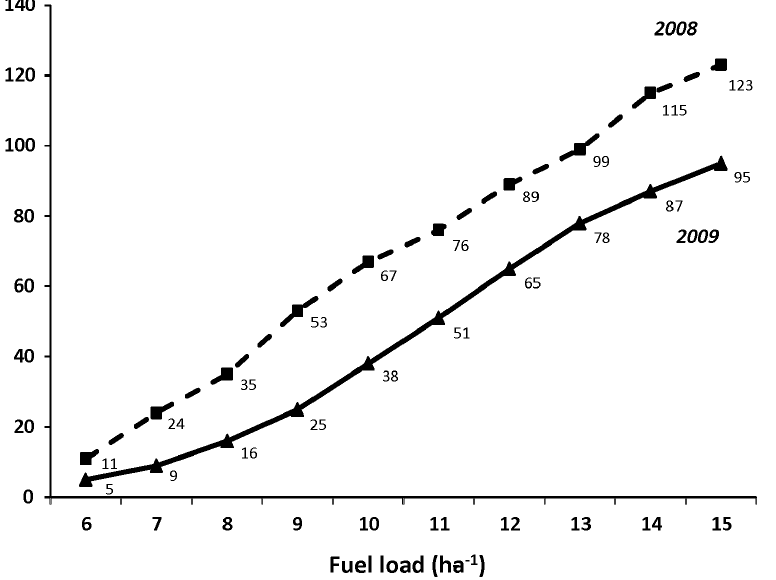
Figure 4. Number of fire ban days in the 2008 (dashed line) and 2009 (solid line) fire season for the Coomalie region, as a function of fuel load. A fire ban is declared when the GFDI $ 50 at any of the three weather stations in the Coomalie region (Batchelor, Middle Point and Darwin).